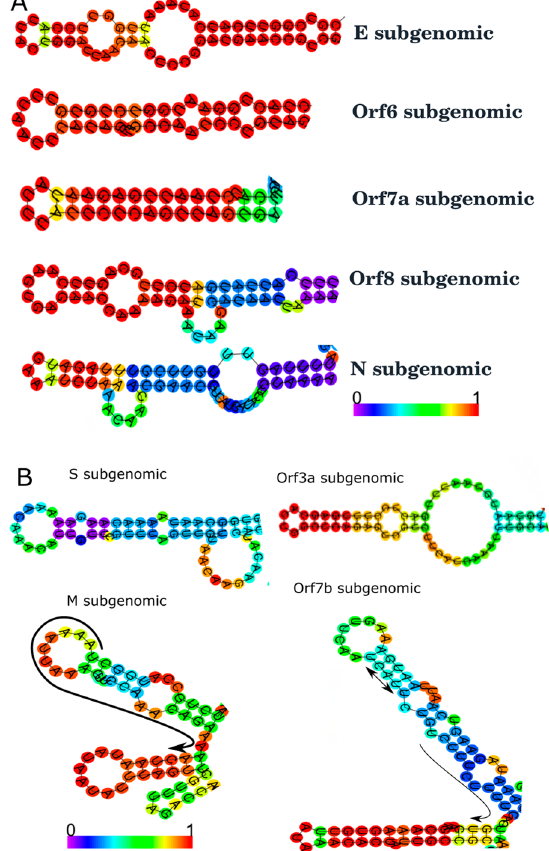
Fig. 2 Secondary structure of consensus sequence of respective negative sense subgenomic RNAs. The secondary structure of each sequence was predicted by using Vienna RNA webserver. The respective portion of hairpin loop is shown with probability in color coding from 0 to 1. Secondary structure of consensus alignment sequence of each subgenomic RNA is shown in panel A and B. Panel A involves consensus secondary structure from subgenomic RNAs those have been detected or mapped at considerable level through NGS reads mapping (Alexandersen et al. 2020). Panel B involves consensus structure of subgenomic RNAs those have been detected at very low or zero level through NGS reads mapping. The complete secondary structure of each subgenomic RNA is provided in supplementary data